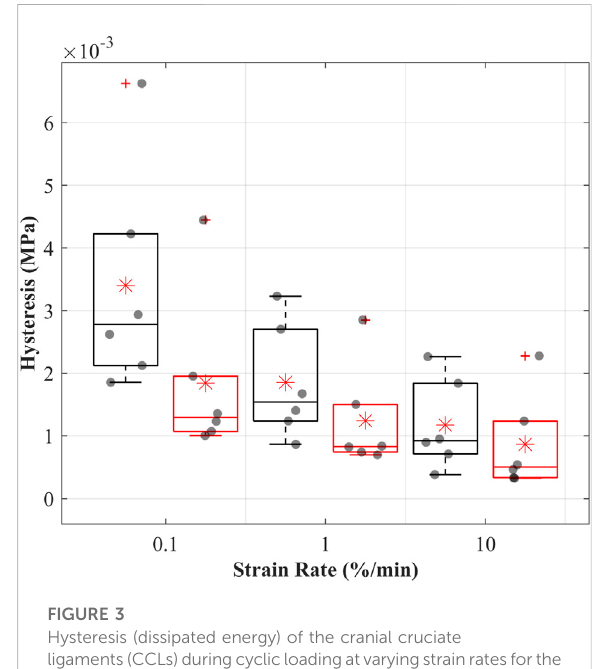
FIGURE 3 Hysteresis (dissipated energy) of the cranial cruciate ligaments(CCLs)duringcyclicloadingatvaryingstrainratesforthe control (black lines) group, where proteoglycans were not depleted, and the treated (red lines) group, where proteoglycans were depleted. The box plot shows individual specimen values (grey dots) and means (red asterisk) during loadingat0.1%/min, 1%/min,and10%/minstrainrates.Theoutliers are indicated with a red plus sign.